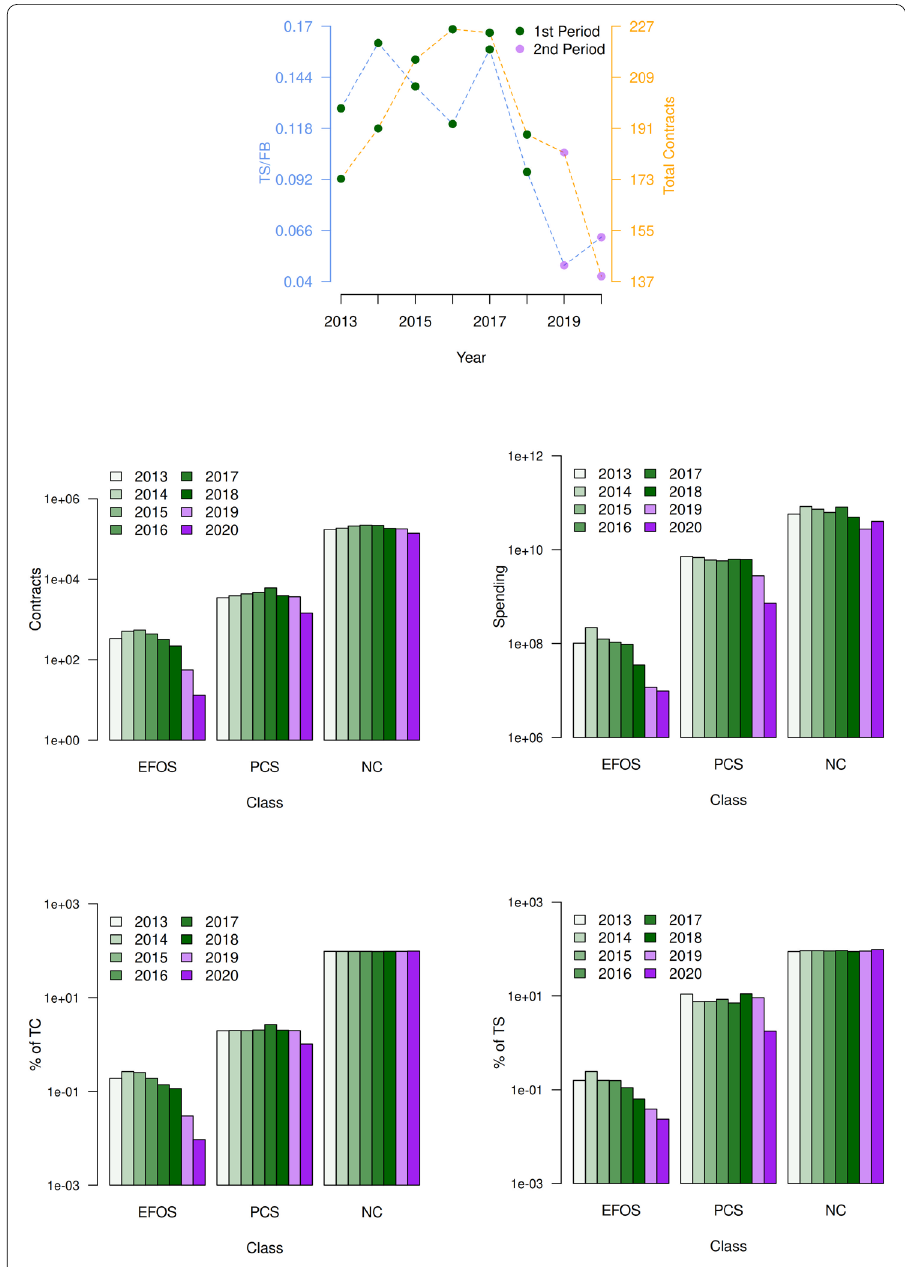
Figure 1 Comparison of the number of contracts and spending per year. Top: Ratio between the total spending reported in the contract source list and federal budget (blue dashed line - in USD PPP), and total number of contracts reported (orange dashed line - in thousands). The green circles represent the 1st government period (2013-2018), whereas the purple circles correspond to the 2nd government period (2019-2020). Center Left: Logarithmic plot of the number of contracts in each class. Center Right: Logarithmic plot of the resources spent in each class. Bottom Left: Logarithmic plot of the percentage of the total contracts in each class. Bottom Right: Logarithmic plot of the percentage of the total spending made in each class. Green and purple bars correspond to the 1st and 2nd government periods respectively